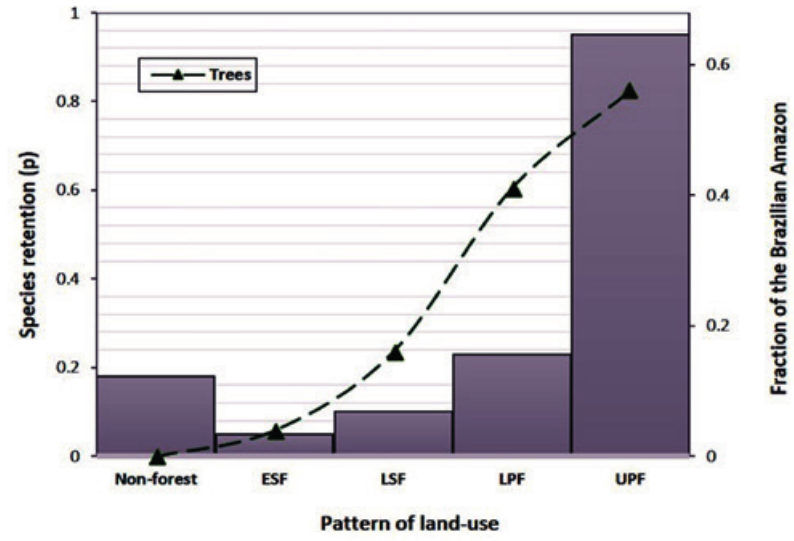
Figure 1 - Patterns of forest tree species retention (p) across a gradient of land-use and land cover in the Brazilian Amazonia, including cattle pastures, early second- growth (eSF), late secondary forest (lSF), selectively-logged primary forest (lPF) and undisturbed primary forest (UPF). Retention is defined as the proportion of species occurring throughout the entire forest matrix that occupies any given land-use. gray shading indicates the overall proportional areas currently represented by these land-uses. Data from: Vieira, ICg, unpublished